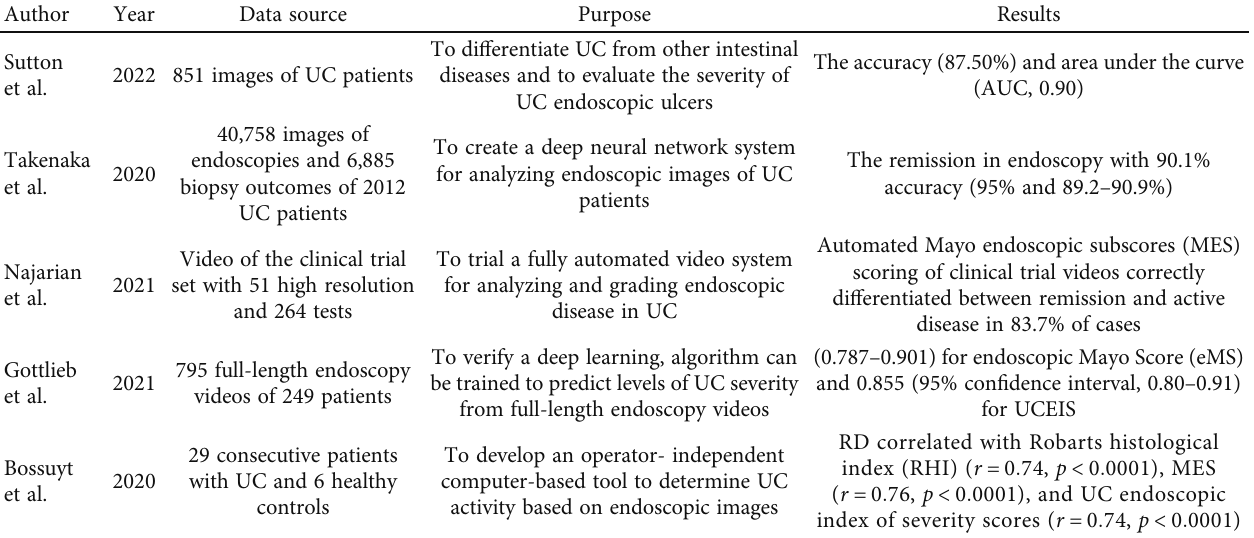
Table 1: Endoscopic AI applications in diagnosing